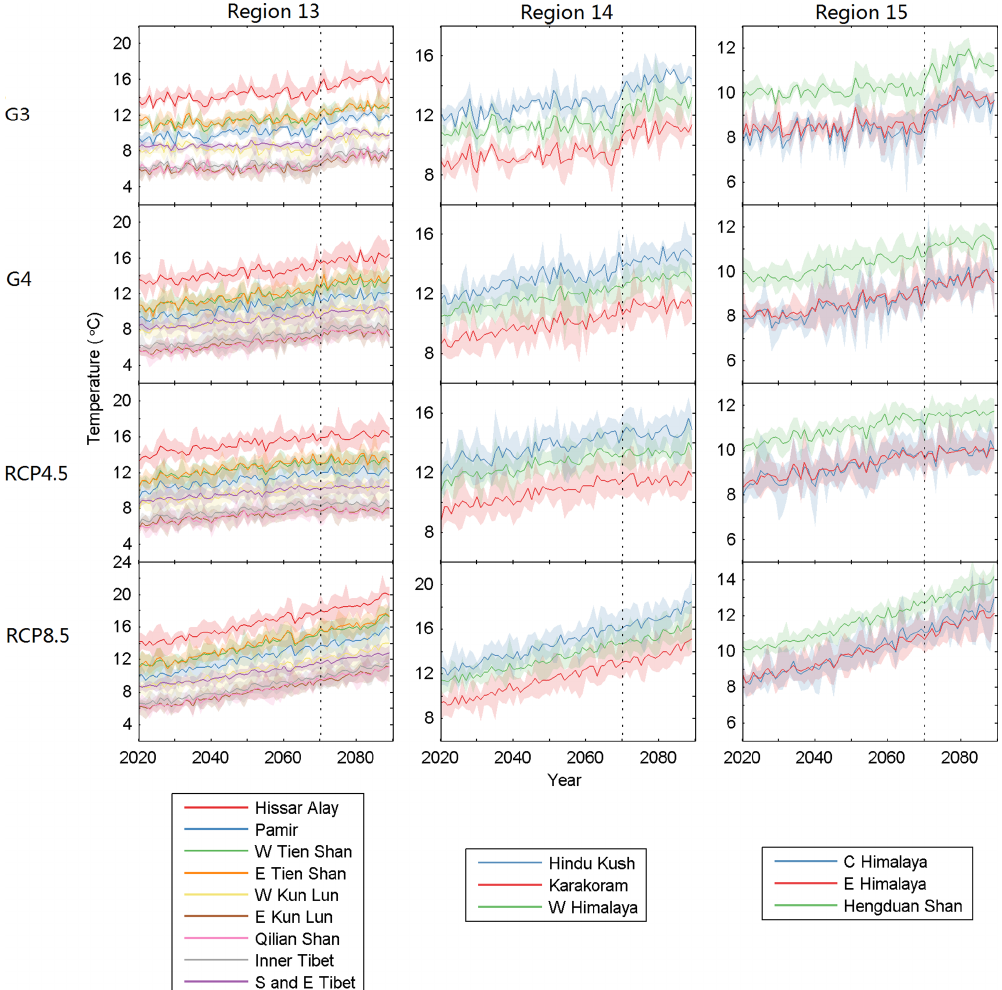
Figure 5. JJA-mean bias-corrected surface air temperature time series from 2010 to 2089 in the sub-regions of Region 13 (left column panels), 14 (middle column panels), and 15 (right column panels) under scenarios by row: G3 (top panels), G4, RCP4.5, and RCP8.5 (bottom panels). Note the different temperature ranges in the panels. The curves and shadings are the ensemble mean and the spread between ensemble members for sub-regions, respectively, which are colour-coded in the